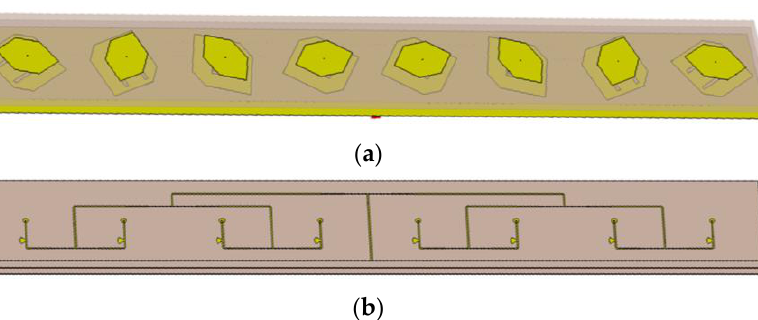
Figure 9. Design 1–8-element patch array. ( a ) Top view. ( b ) Bottom view. Figure 9. Design 1 – 8-element patch array. ( a ) Top view. ( b ) Bottom view.